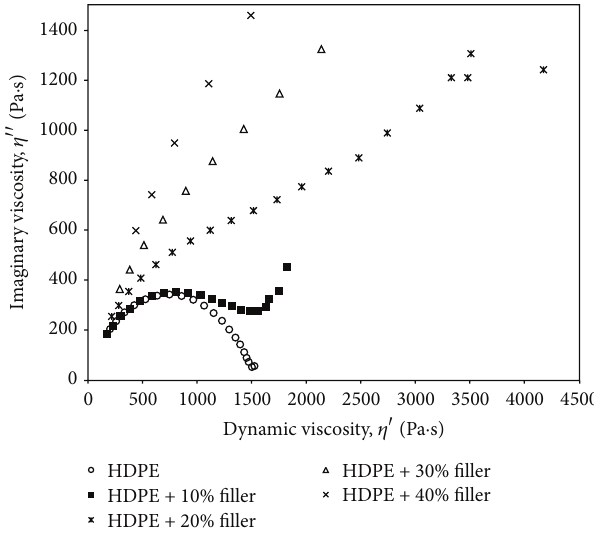
Figure 6: Cole-Cole representation of the viscoelastic properties of neat HDPE and HDPE/filler